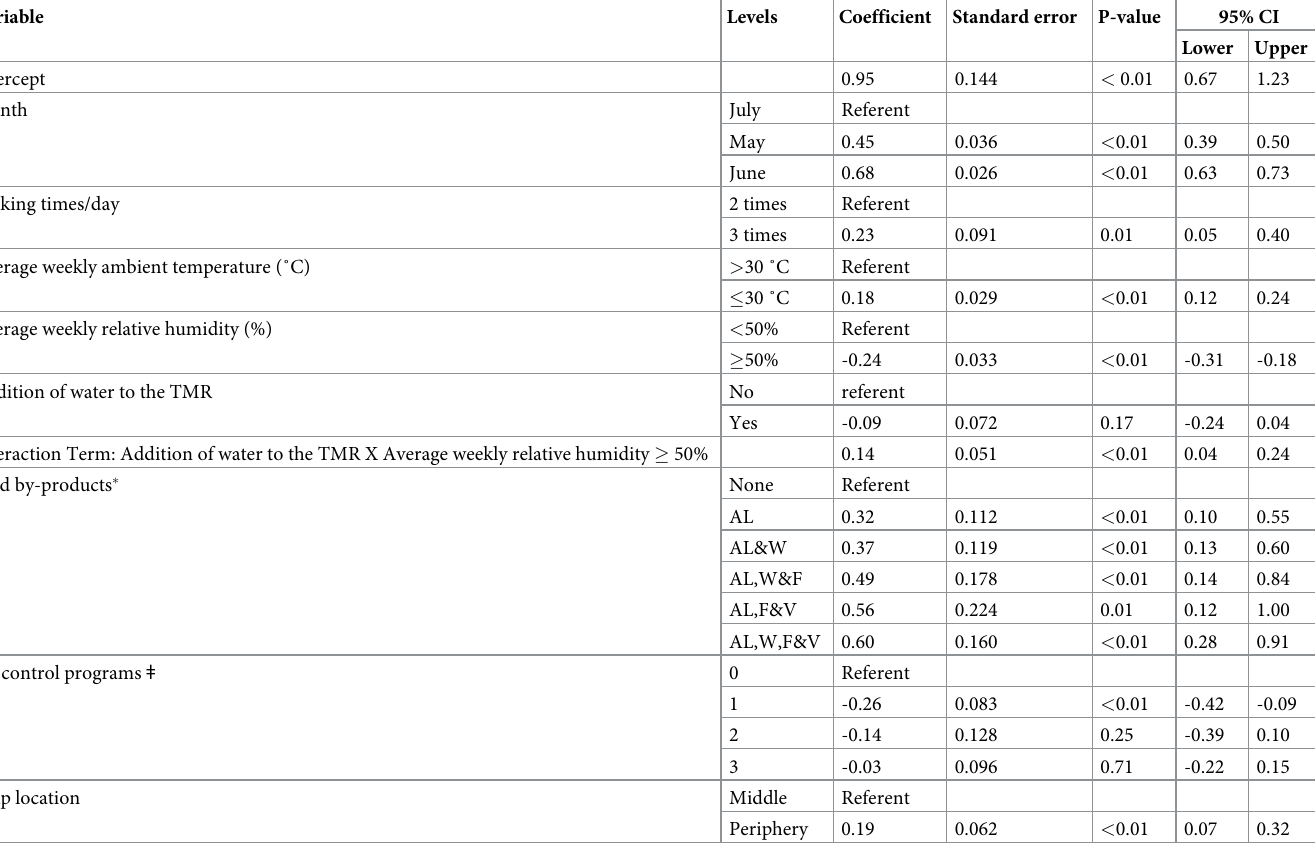
Table 2. Linear mixed model to estimate the association between the outcome (weekly log 10 stable fly trap count) and explanatory variables study month, environ- mental factors, management practices and trap location on the study